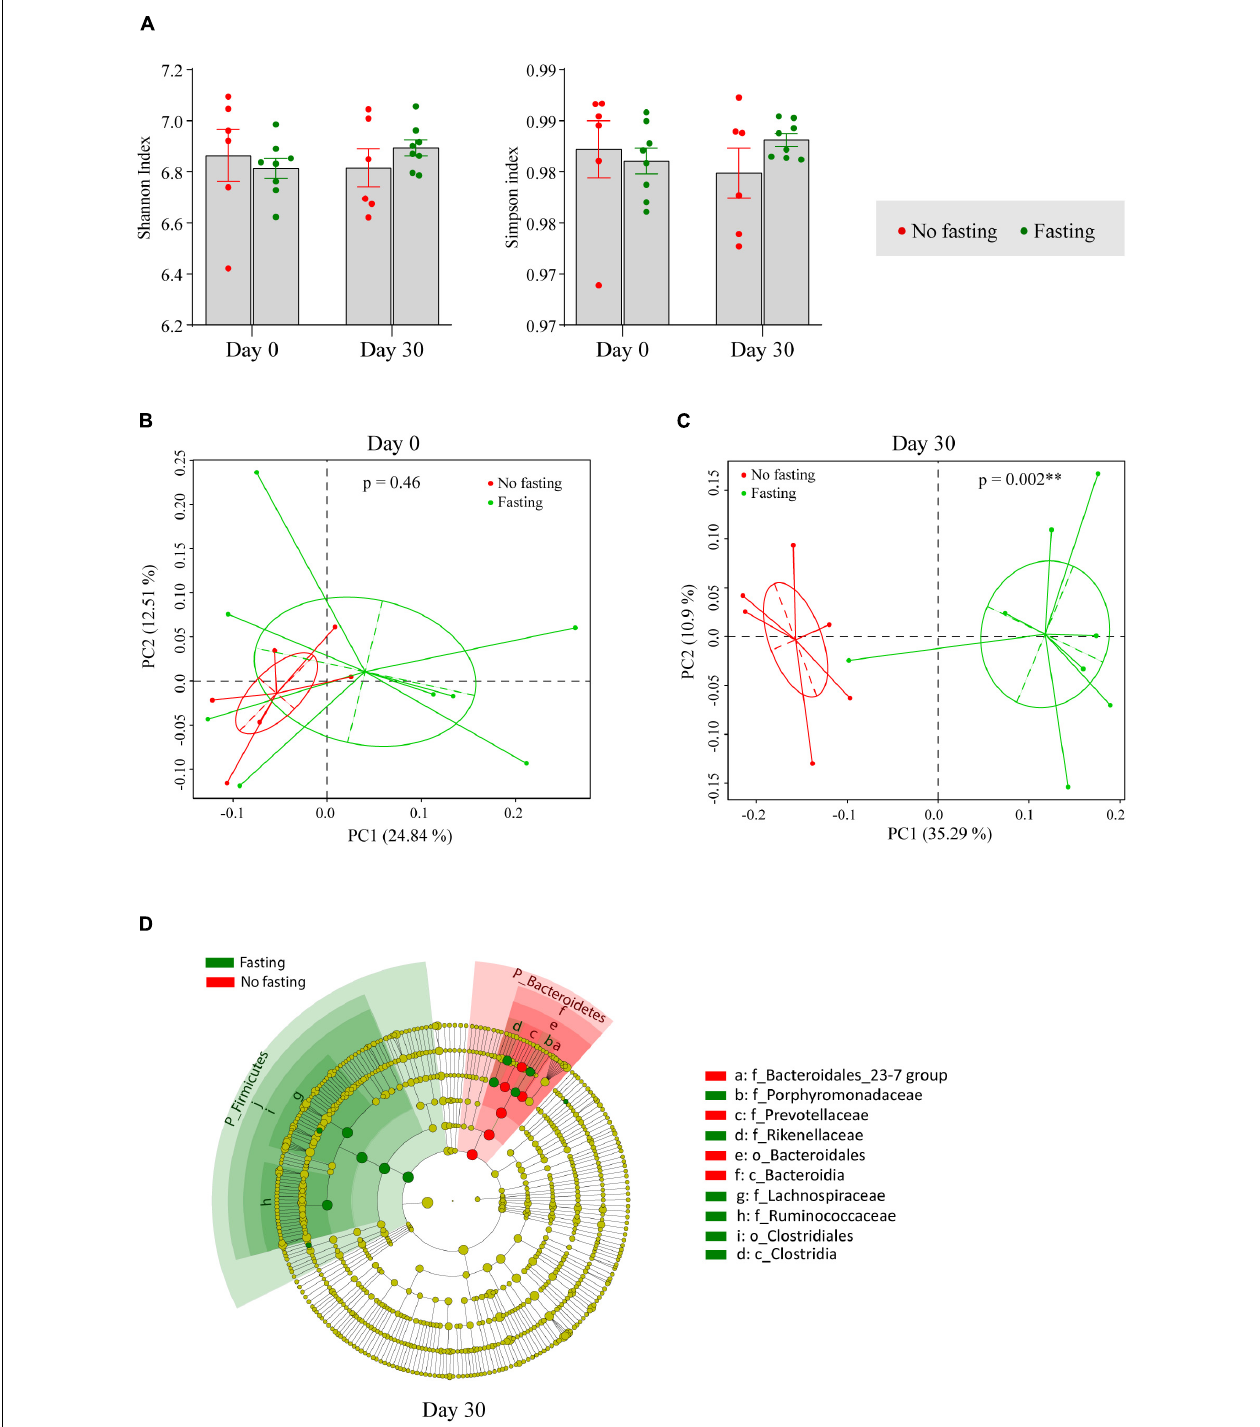
FIGURE 2 | IF shapes the composition of the gut microbiome in BALB/c mice. (A) Alpha diversity indexes were shown as Shannon and Simpson. The significance was calculated by unpaired student’s t -test. Bray–Curtis distance based Principal Co-ordinates Analysis (PCoA) of the gut microbiome in fasting and no fasting mice at day 0 (B) and day 30 (C) . Different color represents different groups or time points of sample collection. Each point corresponds to a community from a single individual. Colors indicate community identity. Ellipses show the 95% confidence intervals. ∗∗ if p -value is less than 0.01 by ANOSIM test. (D) Taxa that show alternative abundance before and after fasting are depicted. Taxa with a log linear discriminant analysis (LDA) score above 4.00 as determined by using linear discriminant analysis coupled with effect size measurements (LEfSe). The hierarchy of the discriminating taxonomic levels was visualized as cladograms allowing taxonomic comparisons before and after